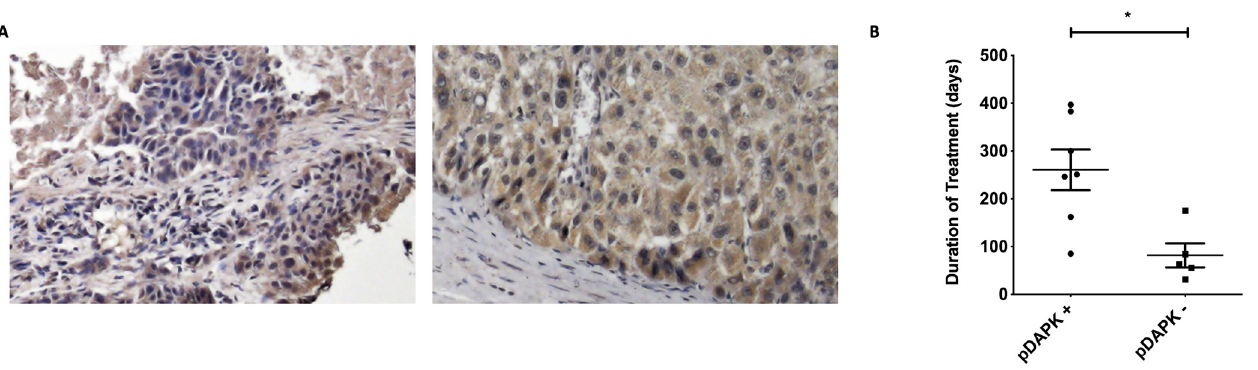
Figure 2. ( A ) Representative patient’s primary tumor IHC of pDAPK S308 positive staining. Left, renal cell carcinoma. Right, hepatic cell carcinoma. 400 × . ( B ) Association of duration of treatment and pDAPK staining status. * p = 0.01.